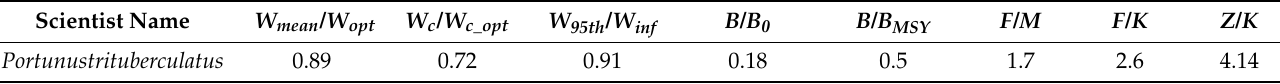
Table 2. Summary of data available for the stock assessments using